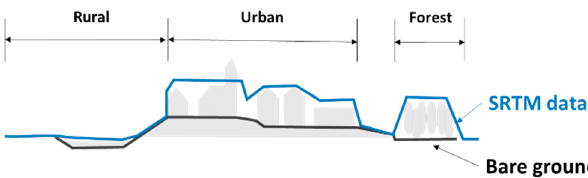
Figure 1. Limitations of Shuttle Radar Topography Mission (SRTM) digital elevation model (DEM) on the scanning of surface [22].